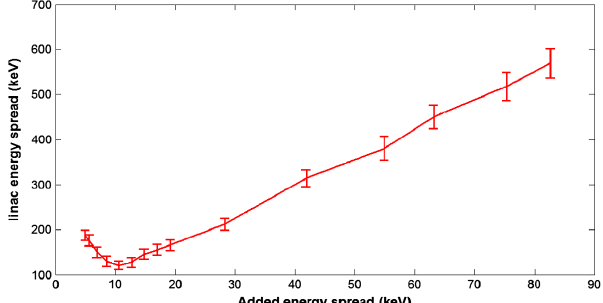
FIG. 15. Slice energy spread as a function of the energy spread added by the LH, for a 500 pC bunch charge compressed in both BC1 and BC2 with a total CF ¼ 7 . Each data point is the average over seven discrete measurements with the plotted error bars calculated as the standard deviation.